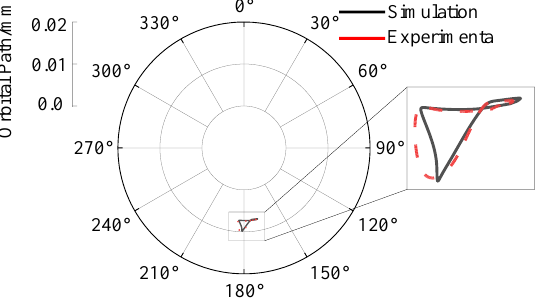
Figure 7. Comparison of the experimental and calculated orbital paths.